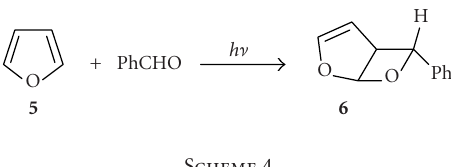
Figure 6: Ring-closure reaction in the formation of the exo isomer of the adduct between furan and